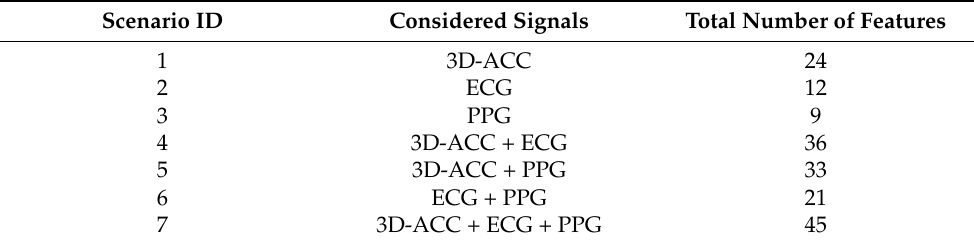
Table 4. Different proposed scenarios to evaluate the level of contribution for each of the 3D-ACC, ECG and PPG signals and their combination, in addition to the total number of applied time- and frequency-domains features after feature